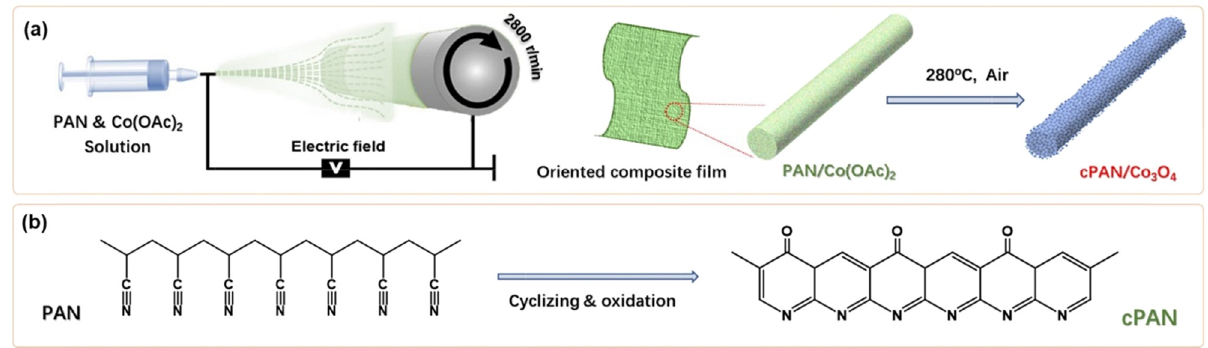
Figure 1: ( a ) Schematic illustration of preparing cPAN/Co 3 O 4 nano fi ber. ( b ) The chemical structure transformation from PAN to cPAN during the thermal